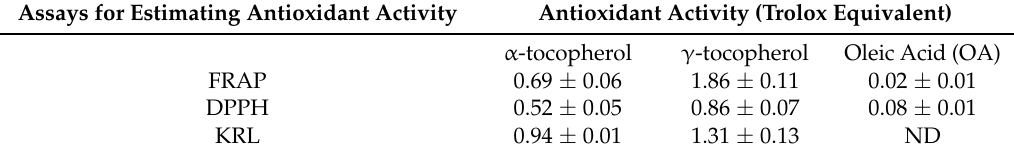
Table 2. Evaluation of the antioxidant properties of α -tocopherol, γ -tocopherol, Trolox, and oleic acid with FRAP, DPPH, and KRL